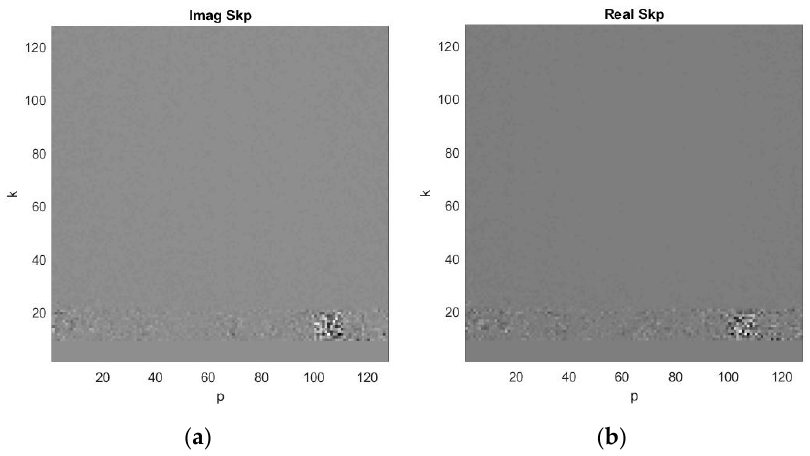
Figure 7. Range compressed ISAR signal obtained after summation of signals in all frequency channels: ( a ) real part; ( b ) imaginary part.